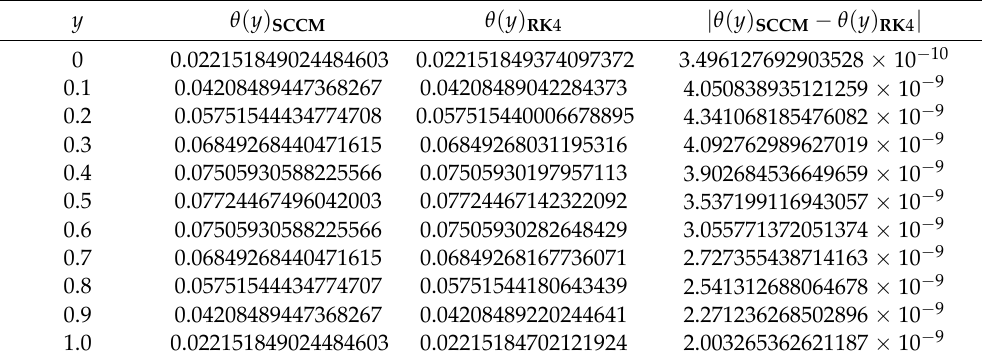
Table 2. Validation of numerical results for temperature.